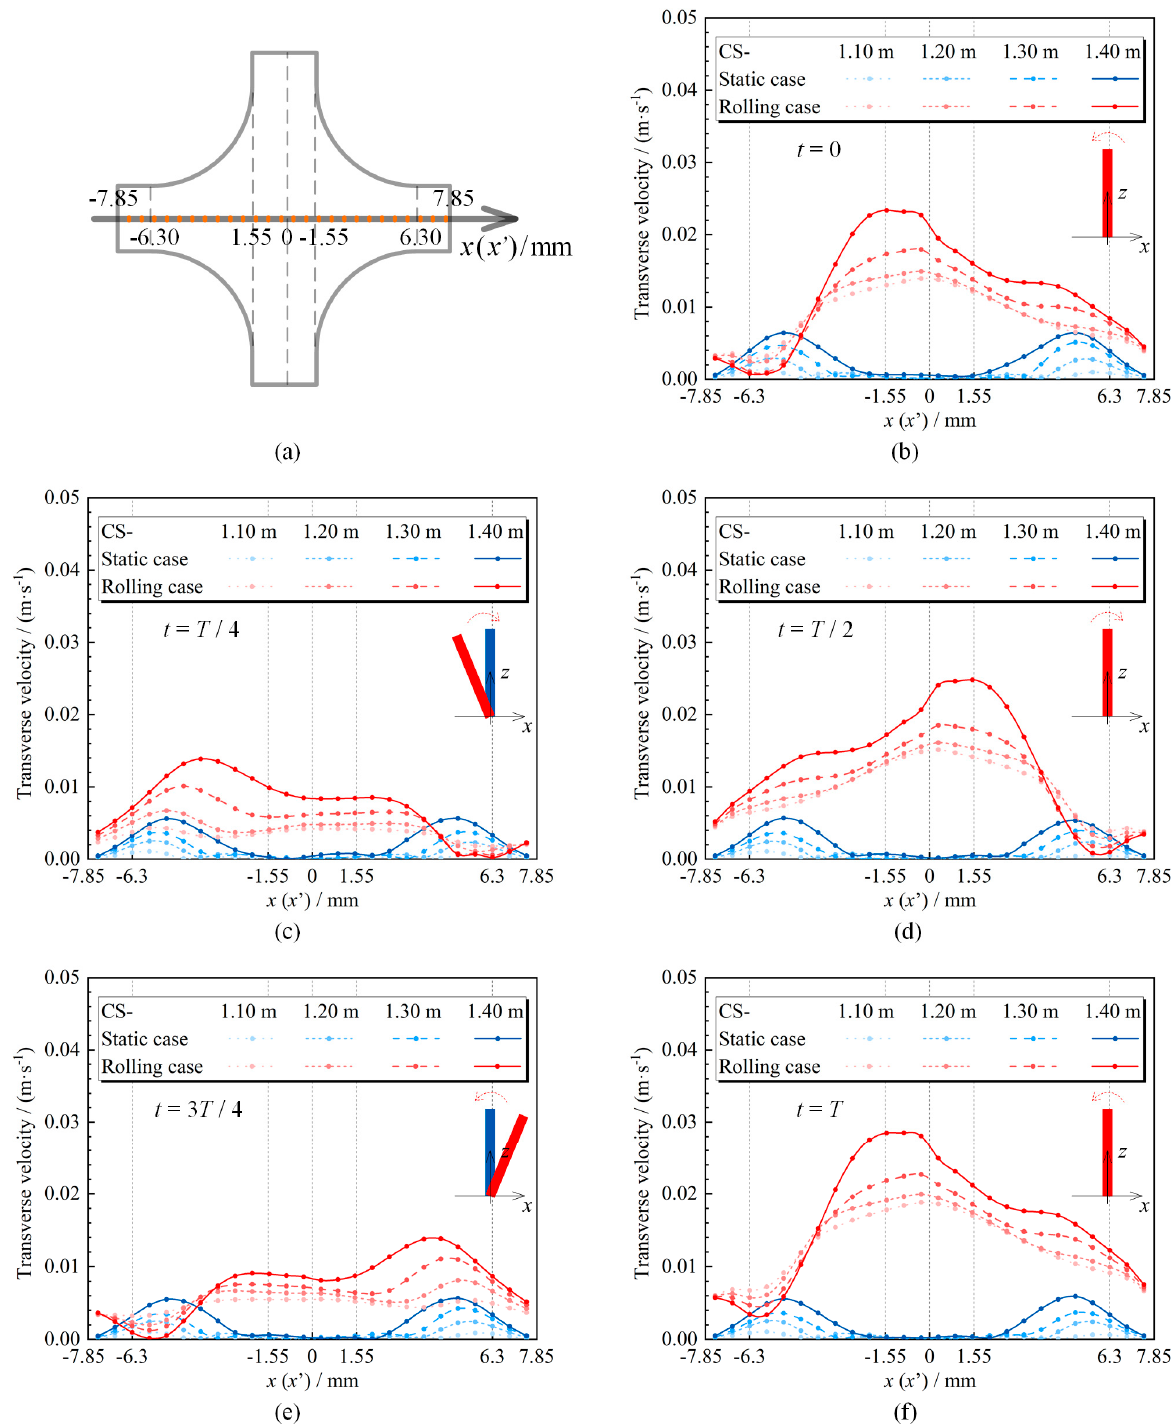
Figure 3. Transverse velocity profiles on the 𝑥 -axis ( 𝑥’ -axis). ( a ) Cross-section of the subchannel; ( b ) 𝑡 = 0 ; ( c ) 𝑡 = 𝑇/4 ; ( d ) 𝑡 = 𝑇/2 ; ( e ) 𝑡 = 3𝑇/4 ; ( f ) 𝑡 = 𝑇 . When the subchannel rotates anticlockwise to the equilibrium position, the angular acceleration is negative (Figure 5b), and the Euler force on the fluid is positive along the x (cid:48) -axis (Equation (11)). Meanwhile, a region consisting of the middle of the cross-section and the two gaps around the x (cid:48) -axis is free of wall impediment. Fluid in this open region flows along the x (cid:48) -axis to the positive direction under the action of the Euler force, and two secondary vortices of the reverse direction emerge at the cross-section (Figure 5c). On